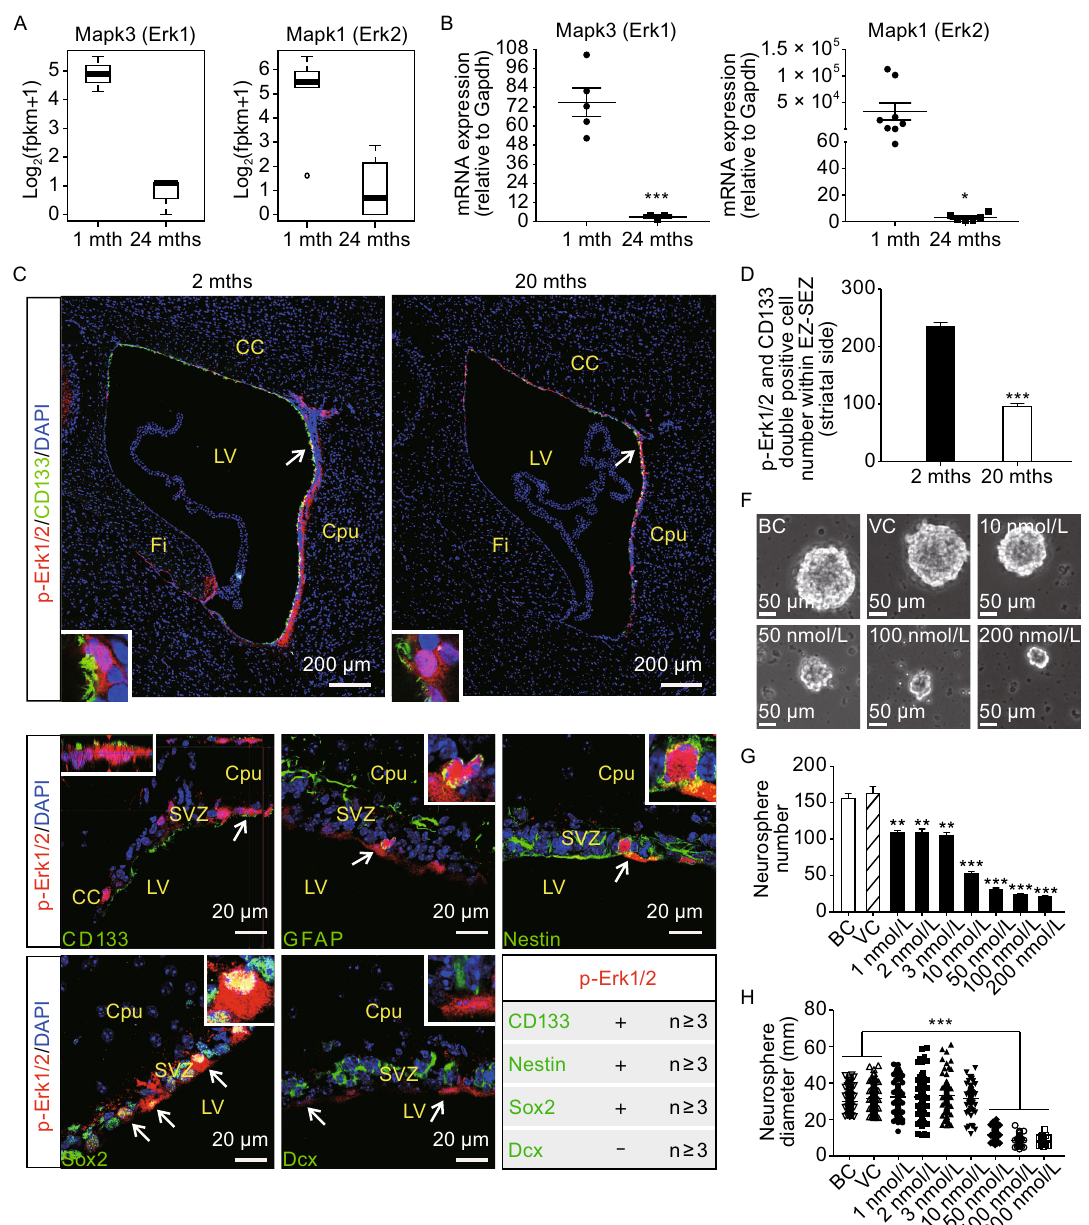
Figure 7. Dampened pErk1/2-Mapkase pathway occurred in aged NSC/NPCs and suppressed clonal expansion capacity of NSC/NPCs. (A) Box plot of Mapk3 and Mapk1, in Prom1 + cells and NBs, respectively, demonstrate reduction with aging based on single cell RNA-seq data. (B) qRT-PCR validated sequencing result in (A). (C) Representative micrograph of sagittal sections of mouse SEZ/SVZ from young (2 mths) and old (20 mths), immunostained with CD133 (green) and p-Erk1/2 (red). Arrows and insets indicate CD133 and p-Erk1/2 double positive cells within SEZ/SVZ. (D) Quanti fi cation of CD133 + /p-Erk1/2 + cells in young (2 mths, n ≥ 3) and old (20 mths, n ≥ 3) mouse SEZ/SVZ (see MATERIALS AND METHODS). (E) Immunostaining micrographs of sagittal sections of the adult mouse SEZ/SVZ demonstrate p-Erk1/2 (red) could be co-located with the NSC markers (green, including CD133, Gfap, Nestin and Sox2), but not neuroblast marker Dcx (green). Arrows and insets indicate p-Erk1/2 + /CD133 + , p-Erk1/2 + / Gfap + , p-Erk1/2 + /Nestin + , p-Erk1/2 + /Sox2 + NCS/NPCs, as well as p-Erk1/2 − /Dcx + neuroblasts within SEZ/SVZ. (F) Representative images of decreased neurosphere formation after exposure to 10 nmol/L, 50 nmol/L, 100 nmol/L, 200 nmol/L speci fi c inhibitor of Erk1/2 phosphorylation (SCH772984), as compared to blank controls (BC) and vehicle controls (VC). (G and H) Quanti fi cation of decreased neurosphere numbers and size after exposure to SCH772984. Error bars indicate the SEM from three independent experiments. ** P < 0.01; *** P <